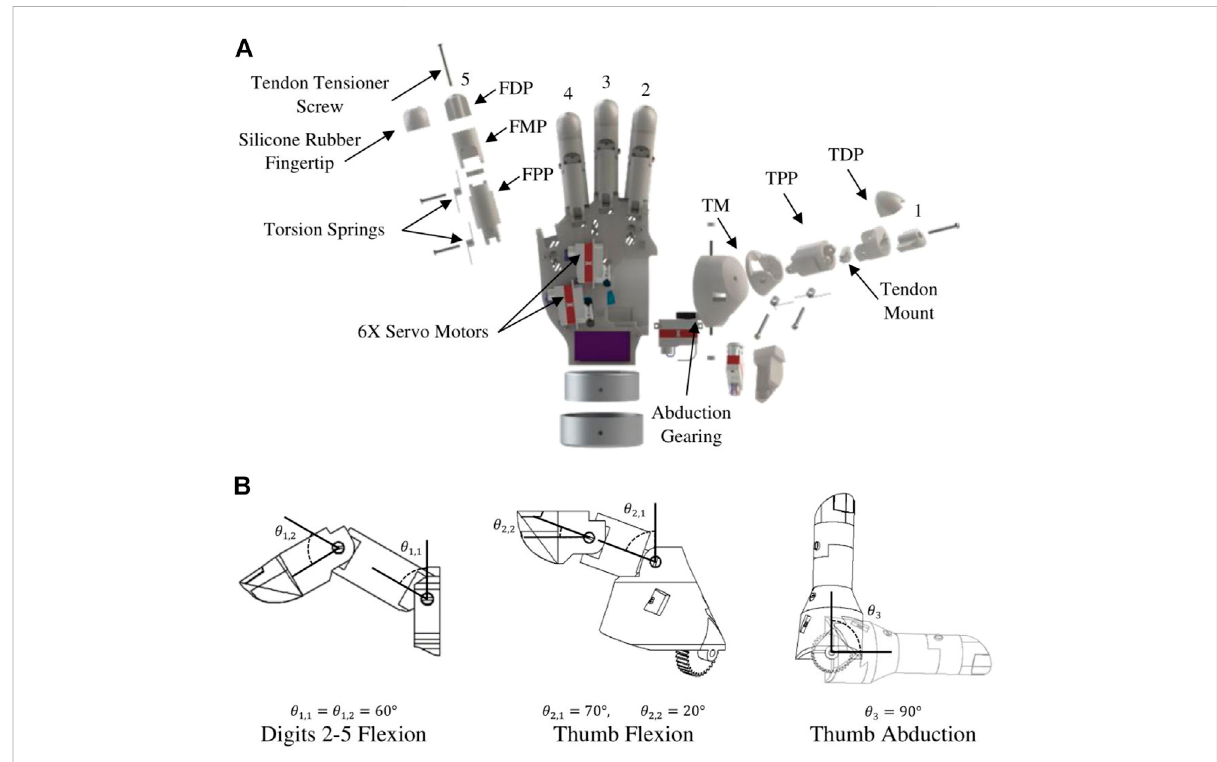
FIGURE 6 A detailed illustration of the mechanical features of the BEAR PAW. (A) Shows an exploded view of individual digits 1 – 5 highlighting key components of the mechanical design. (B) Provides the range of motion for each degree of actuation. Digits 1 – 5 are labeled with acronyms: fi